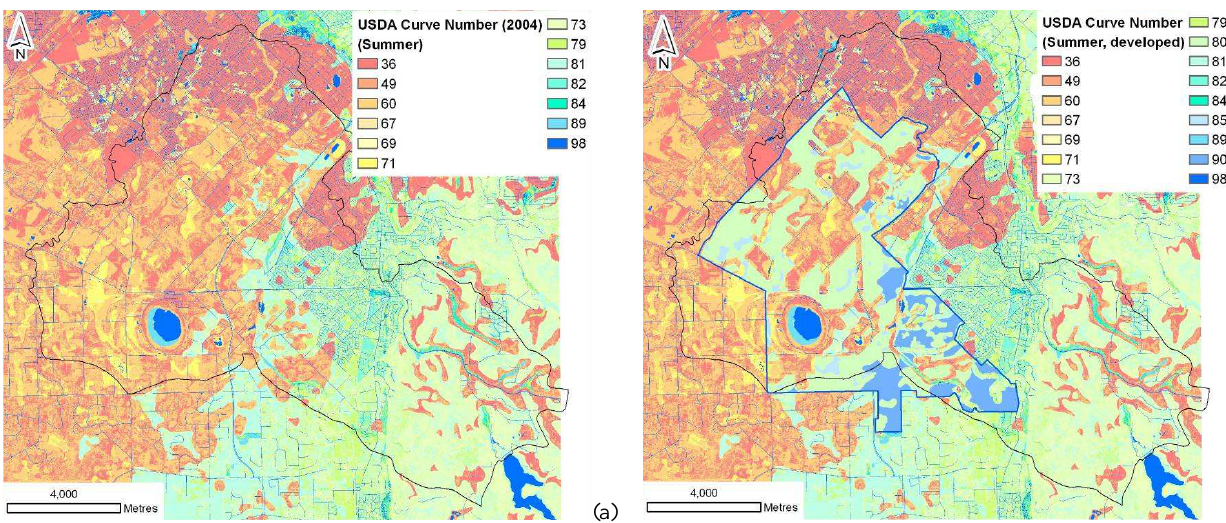
Fig. 4. USDA Curves applied to the volumetric runoff analysis for (a) predevelopment and (b) post-development